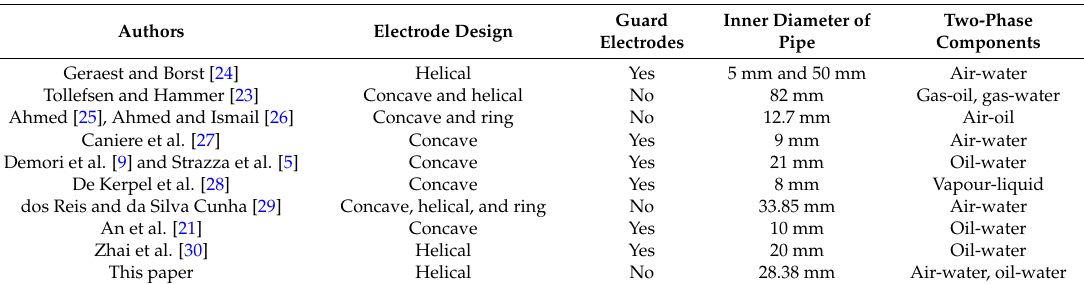
Table 1. A brief review of holdup measurement in horizontal two-phase flow using two-electrode capacitance